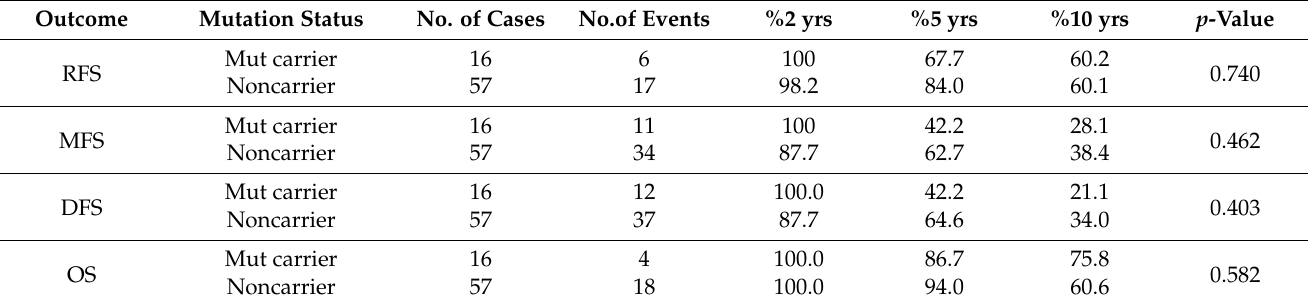
Table 3. Survival outcomes in patients harboring BRCA1 mutation c.5205delA ( p .Val1736Serfs*29) as compared to non-carriers.